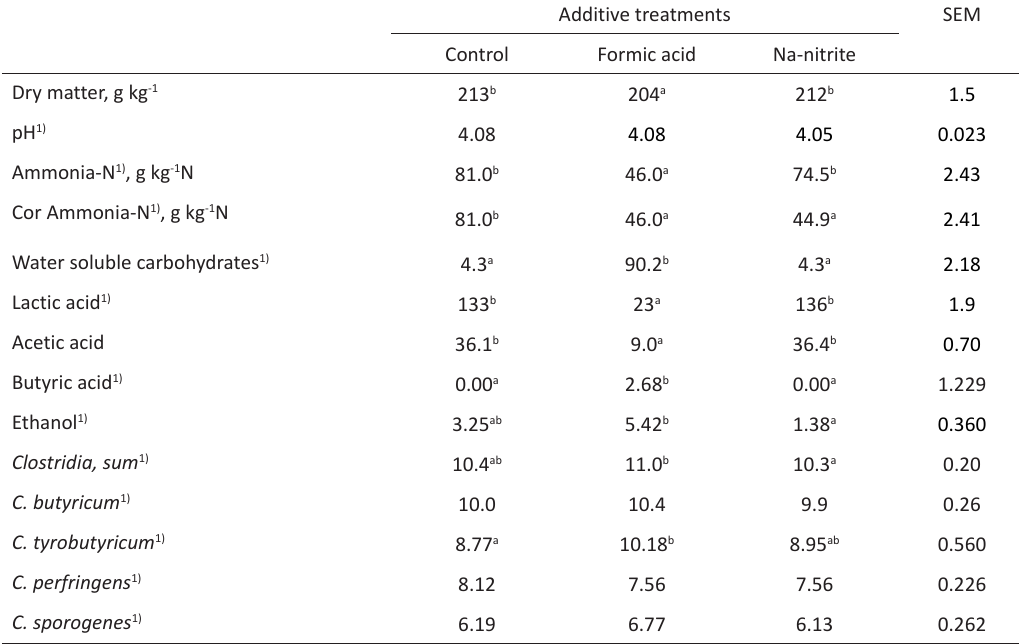
Table 3. The effect of additive treatment on wilted red clover-based silage fermentation quality (g kg -1 dry matter, if not otherwise stated) and number of clostridia as log copies g -1 fresh matter (n = 4) (experiment 1)